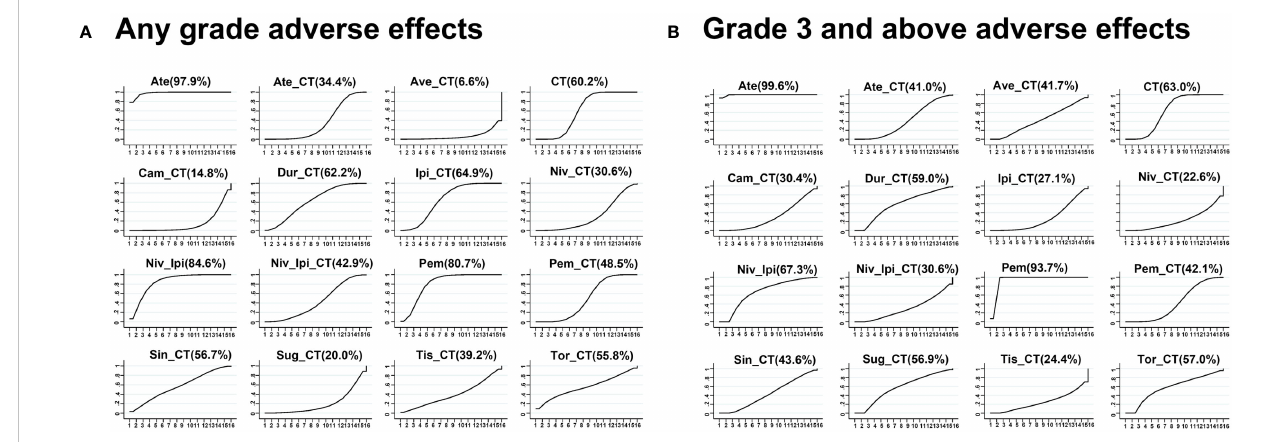
FIGURE 5 Network meta-analysis ranking diagram based on all adverse events (A) or grade 3 or higher adverse events (B)